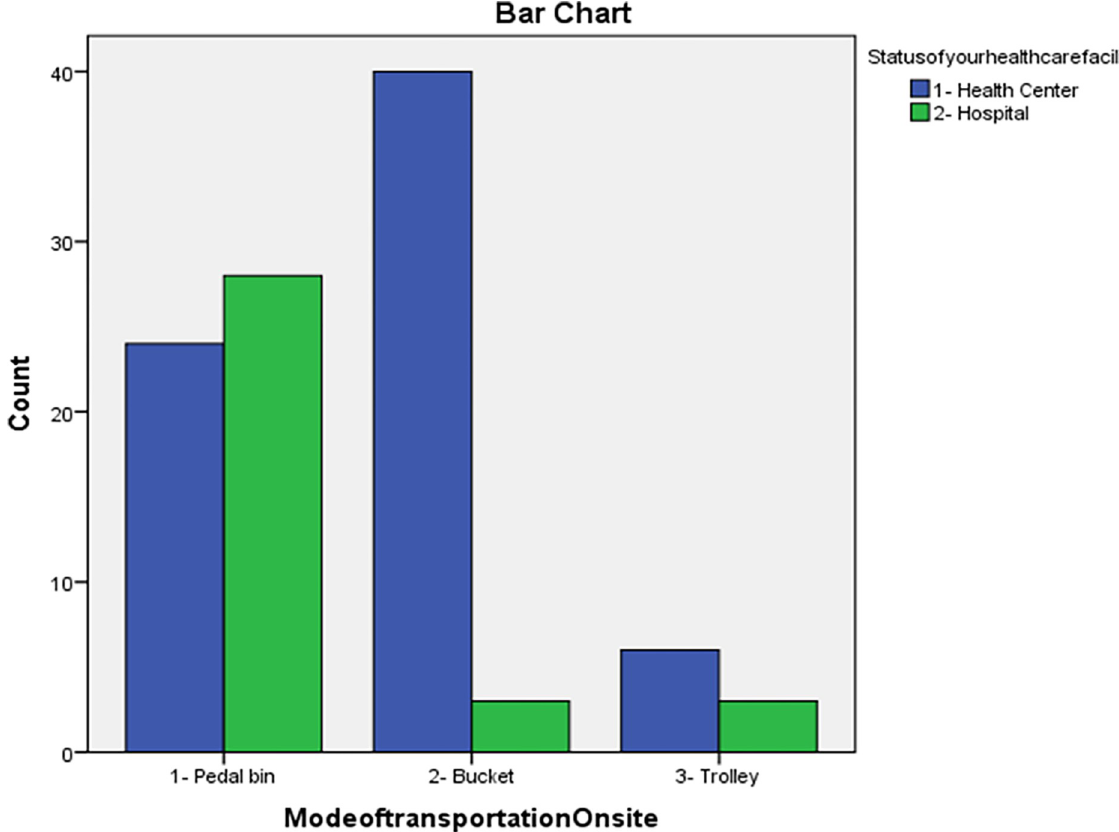
Fig 4. On-site means of transportation for HCW in the selected healthcare facilities, Addis Ababa City Administration, February